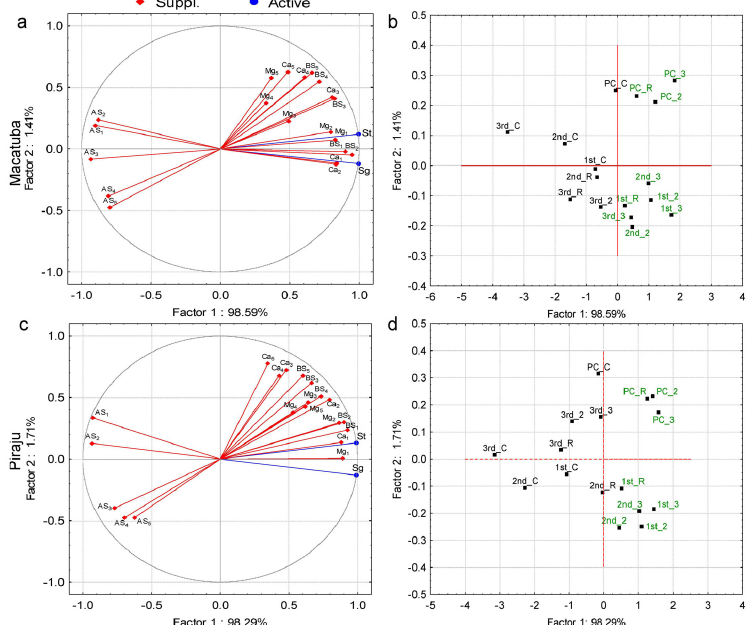
Figure 2. Projection of the dataset subjected to principal component analysis based on the correlations of stalk (St) and sugar (Sg) yields with ( a , c ) soil chemical attributes (Ca, calcium; Mg, magnesium; BS, base saturation; and AS, aluminum saturation) and depths (1, 0.0-0.2 m; 2, 0.2-0.4 m; 3, 0.4-0.6 m; 4, 0.6-0.8 m; and 5, 0.8-1.0 m); and ( b , d ) lime rate (C, control; R, recommended lime rate; 2, 2x recommended lime rate; 3, 3x recommended lime rate) at Macatuba and Piraju under deep strip-tillage (DT) for plant cane (PC) and first (1st), second (2nd), and third (3rd) ratoons.